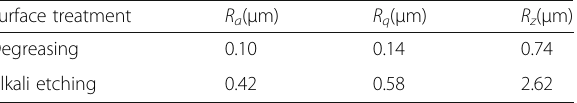
Table 1 Surface roughness of the Al surface after: (a) degreasing and (b) alkali etching Surface